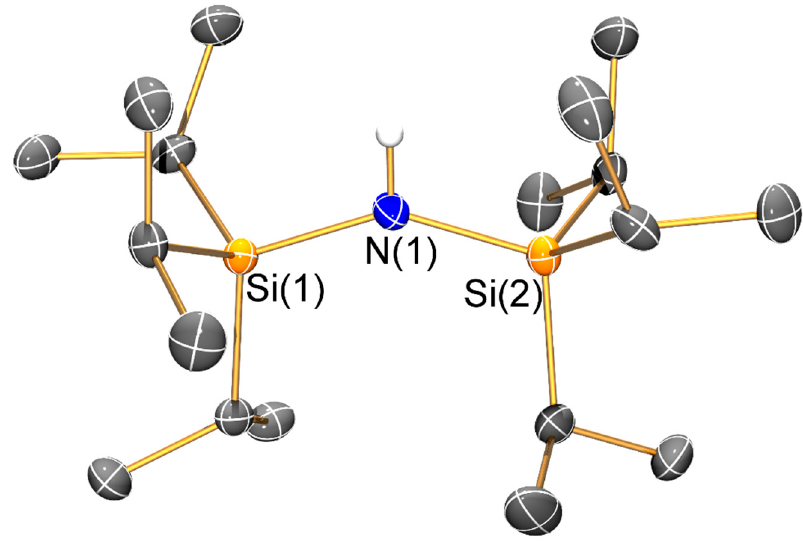
Figure 2. Molecular structure of {HN(Si i Pr 3 ) 2 } ( 1 ) with selective atom labelling. Displacement ellipsoids set at 30% probability level and hydrogen atoms apart from H1 omitted for clarity.